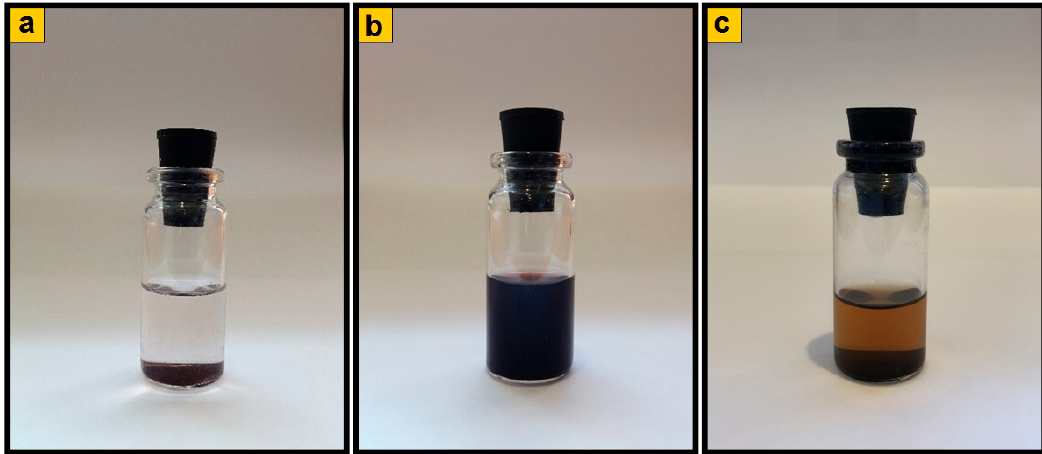
Figure 13. Suspensions of Fe 3 O 4 / SWCNT ( a ) and Fe 3 O 4 / SWCNT / PDPAC, prepared in alkaline ( b ) and acidic media ( c ) in ethanol. ( a , c )—in 5 min, ( b )—in 8 months.